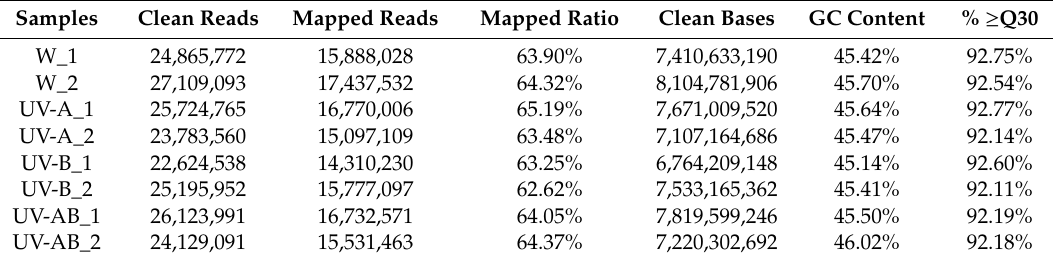
Figure 3. Activities of CHS, CHI, F3H, F3 ′ H, F3 ′ 5 ′ H, DFR, LAR, ANS, and ANR ( A – I ). The activities of each enzyme in one bud and two leaves of ‘Ziyan’ tea plant under different treatments were detected. CHS, chalcone synthase; CHI, chalcone isomerase; F3H, flavone 3-hydroxylase; F3 ′ H, flavonoid 3 ′ -hydroxylase; F3 ′ 5 ′ H, flavonoid 3 ′ ,5 ′ -hydroxylase; DFR, dihydroflavonol 4-reductase; LAR, leucoanthocyanidin reductase; ANS, anthocyanidin synthase; ANR, anthocyanidin reductase. Error bars indicate MS ± SD of three biological replicates. Different letters among treatments indicate a significant difference at p < 0.05 based on the analysis of variance (ANOVA) (Duncan test). Table 4. Statistics of Illumina reads and comparison with tea pant genome